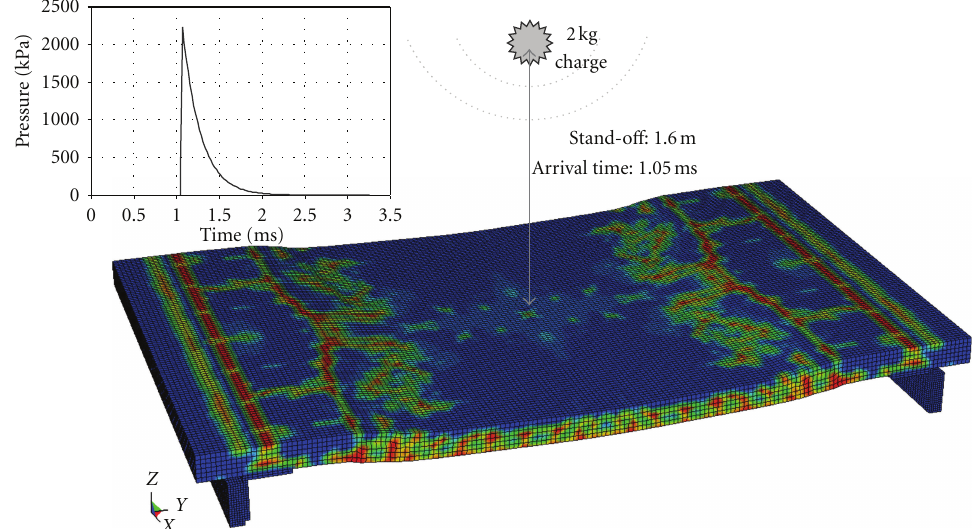
Figure 4: The deflected profile and damage contour of the unretrofitted (Bare) panel due to the blast load. Inset: Blast reflected pressure-time history.